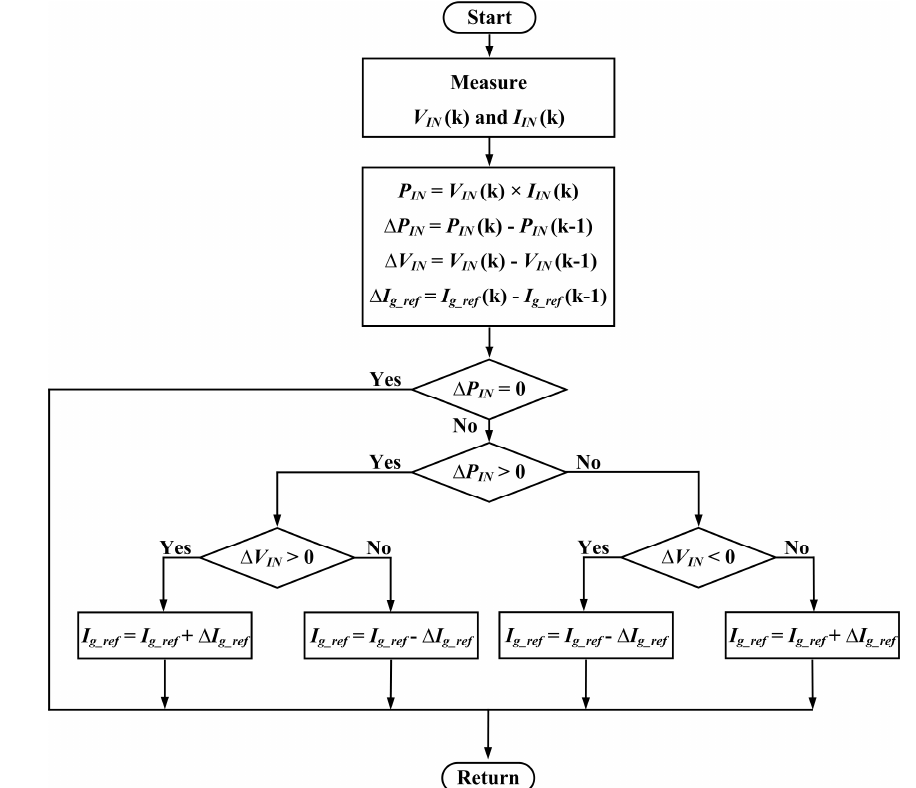
Figure 6. The perturb and observe MPPT algorithm.